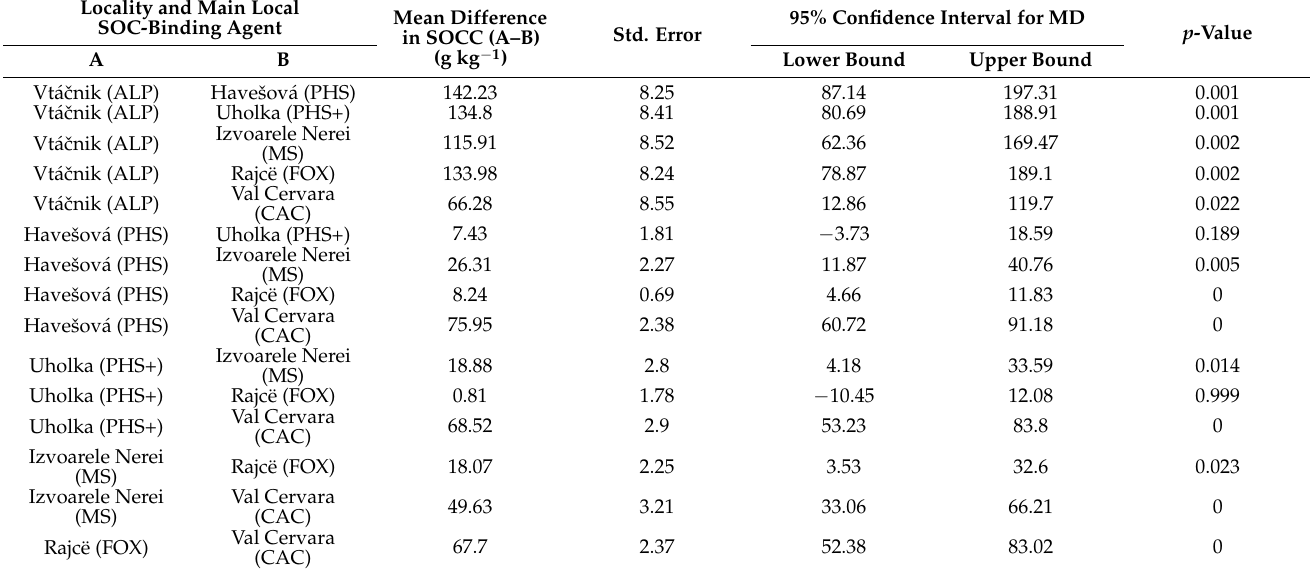
Table 5. Games–Howell post-hoc multiple comparison test of soil organic carbon concentration (SOCC) differences between localities, characterized by main SOC-binding agents and mechanisms: ALP—allophane, PHS—phyllosilicates, MS— micaceous sand, FOX—iron oxides, CAC—Ca 2+ and carbonates. PHS+ represents the higher proportion of phyllosilicates in Uholka compared to Havešov á (PHS). Locality and Main Local SOC-Binding